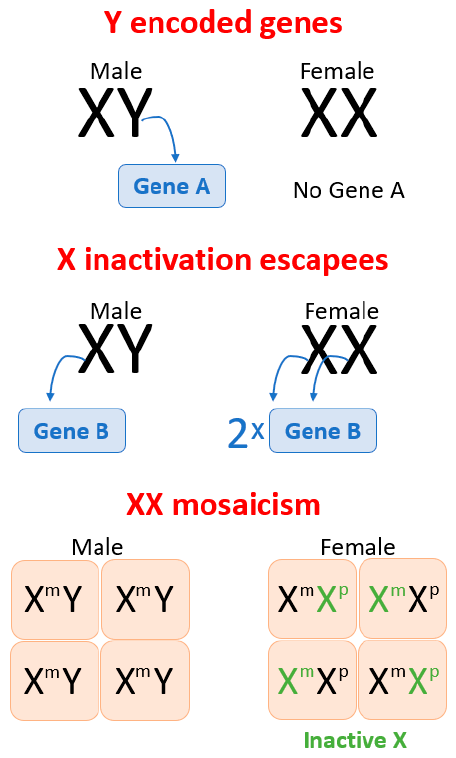
Figure 1. Possible mechanisms, underlying how sex chromosomes induce sex differences between males (XY) and females (XX), include: (1) genes located on the Y chromosome that are present in XY cells and not present in XX cells; (2) genes located on the X chromosome that escape X inactivation and thus are more highly expressed in female cells than in male cells; (3) XX mosaicism which is a random inactivation of one of the X chromosomes, maternal X (X m ) or paternal X (X p ) in different cells. This process is not completely random and, in some females, X m or X p is inactivated in more than 50% of cells, which leads to X skewing (not depicted on Figure 1). Males (XY) have X m in every cell and hence are not XX mosaic so that mutations impairing gene function cause more severe phenotypes in males.